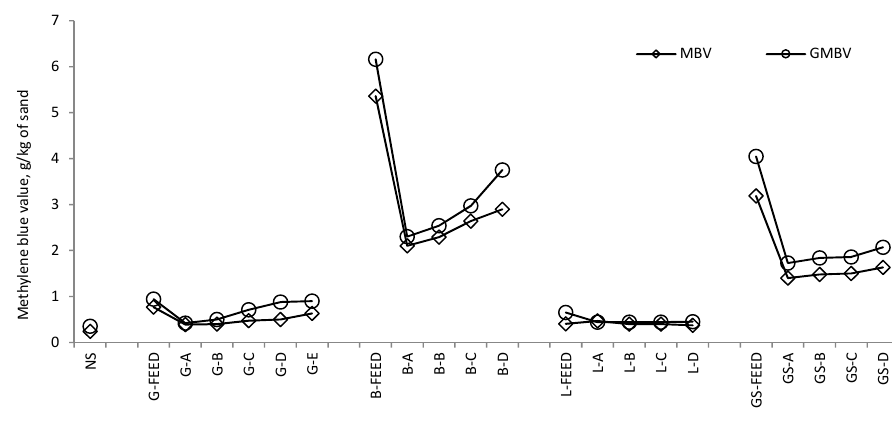
Figure 5. Methylene blue value and Grace rapid clay test results.